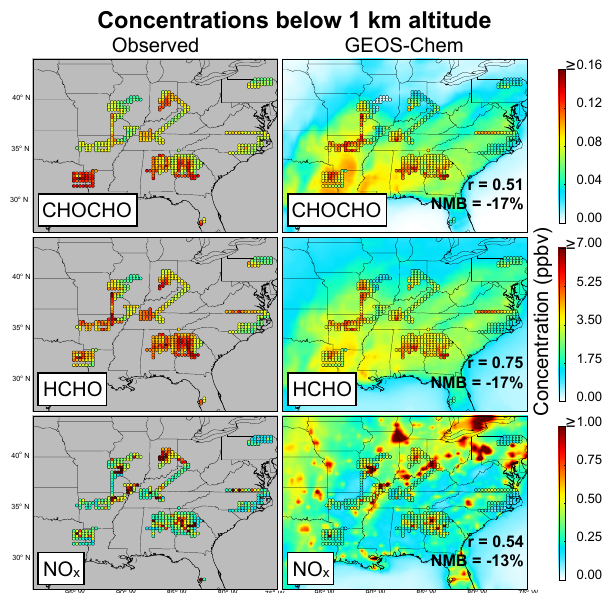
Figure 4. CHOCHO, HCHO, and NO x concentrations below 1kma.g.l. during SENEX (1 June–10 July 2013). The grid squares show daytime aircraft observations compared to the colocated GEOS-Chem model values on the 0.25 ◦ × 0.3125 ◦ model grid. Background contours in the right panels show the average model- simulated concentrations at 13:00–14:00LT for the SENEX period. Comparison statistics between model and observation grid squares are shown as the correlation coefficient r and the normalized mean bias (NMB). Correlation statistics for NO 2 exclude urban plumes in the observations ([NO x ] > 4ppb) as these would not be resolved at the scale of the